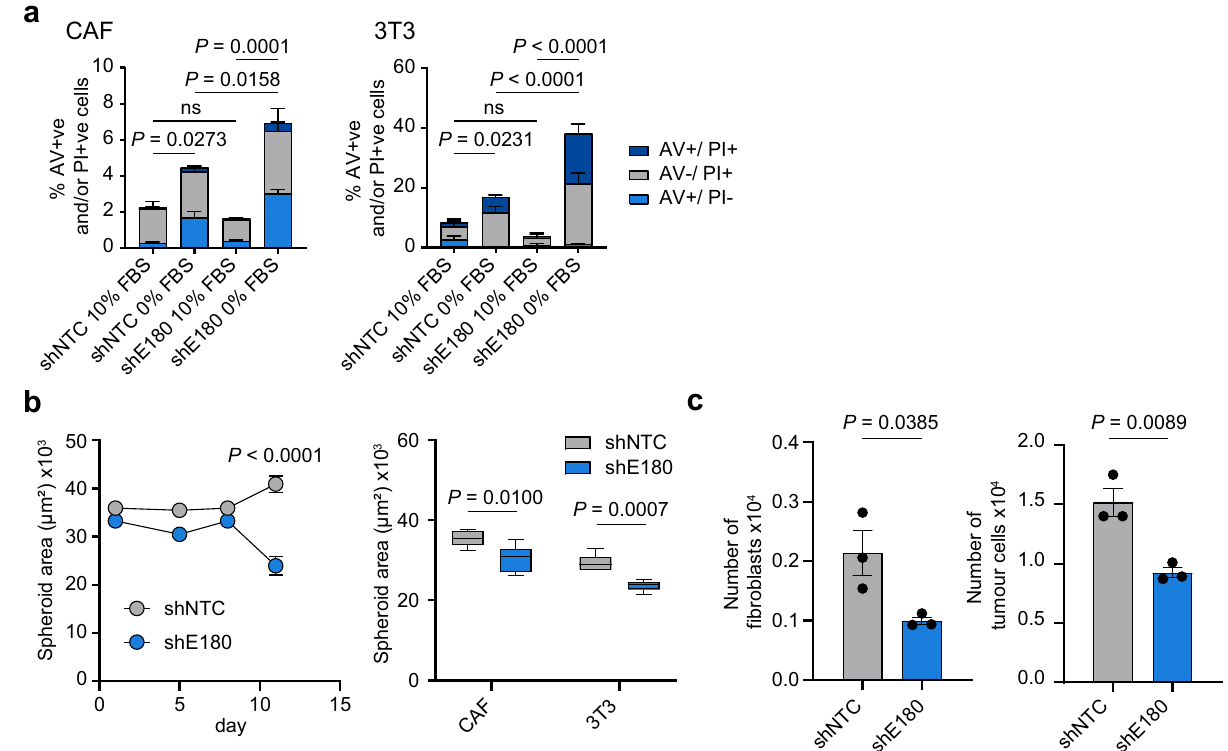
Fig. 6 Reduced viability of Endo180-de fi cient CAFs. a shNTC and shE180 CAF and 3T3 cells were plated in anoikis conditions ( fl at bottom low adherence 6-well plates) in DMEM plus 0 or 10% FBS. After 24 h level of cell death was measured by Annexin V (AV)/ PI staining ( n = 3 per condition; mean values ± SEM, one-way ANOVA of total % AV + ve and/or PI + ve cells). b Left panel, 900 shNTC or shEndo180 CAFs were plated into U-bottom wells and growth of suspension aggregates size monitored over time ( n = 6; mean values ± SEM, two-way ANOVA). Right panel, 900 CAFs or 3T3 fi broblasts were plated into U-bottom wells and suspension aggregate size measured on day 10. Box plots shows median and 25th – 75th quartiles, whiskers show minimum and maximum. ( n = 6; mean values ± SEM, two-sided t -test). c 300 D2A1 and 600 GFP-CAFs cells were co-cultured in U-bottom plates. After 8 days, spheroids were dissociated and the number of GFP-positive CAFs and GFP-negative tumour cells counted ( n = 3 per condition; mean values ± SEM, two- sided t -test). Non-signi fi cant (ns) P values > 0.05. Source data are provided as a Source Data fi “ TWOMBLI ” plugin 38 , to quantify matrix density and (an-)isotropy of fi bres. Data or plated onto fi broblast-derived ECM. Tumour colonies were stained 7 days later with crystal violet (Sigma). Plates were scanned using the GelCount (Oxford shown are matrix density, calculated as (100 − HDMvalue × 100) to convert from Optronix) and image analysis performed using GelCount software and FIJI.